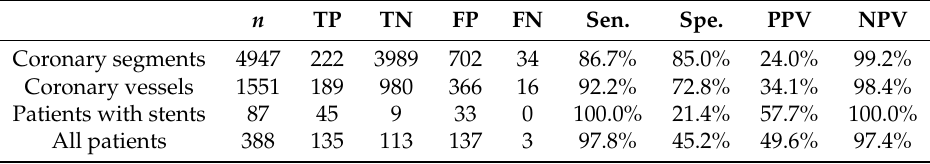
Table 4. Diagnostic performance of cCTA in comparison to ICA with